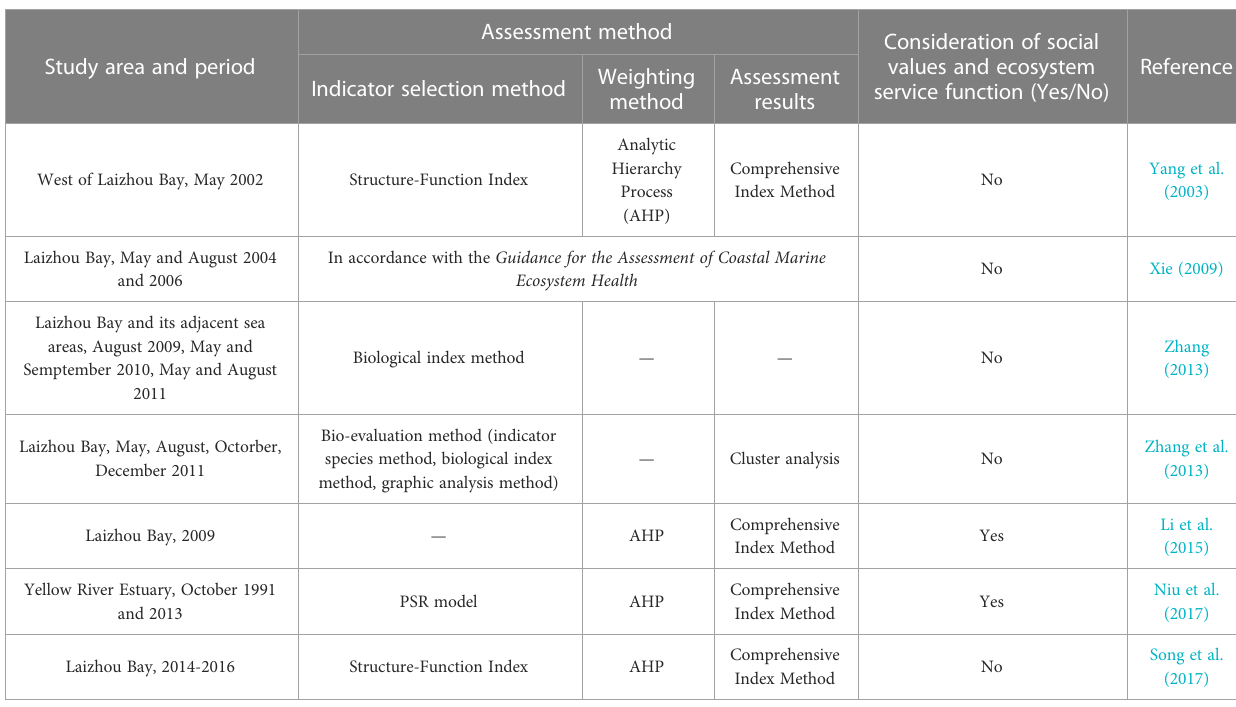
TABLE 1 Summary of existing studies on ecosystem health assessment in Laizhou Bay.